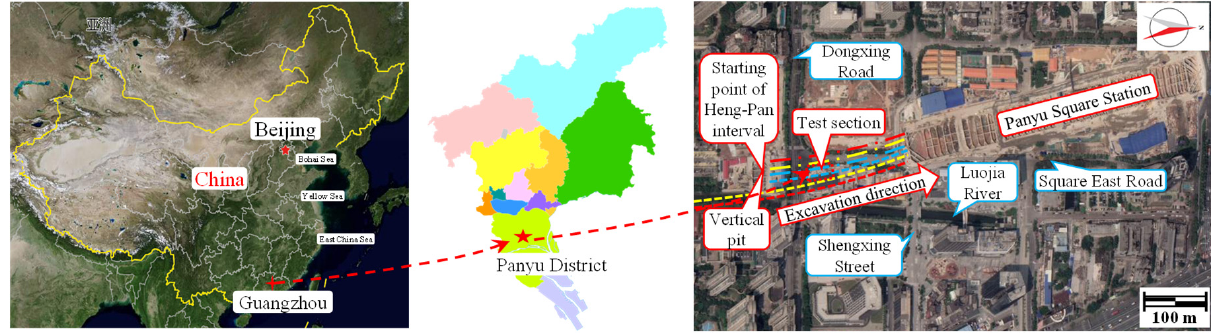
Figure 1. The geographical location of underground tunnel project in urban area in Guangzhou, China.